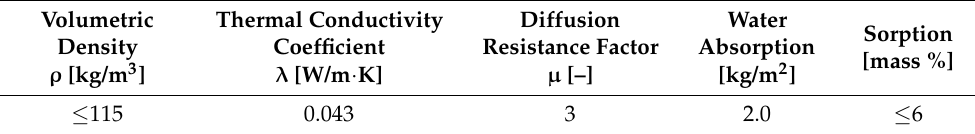
Table 2. Selected features of the reference